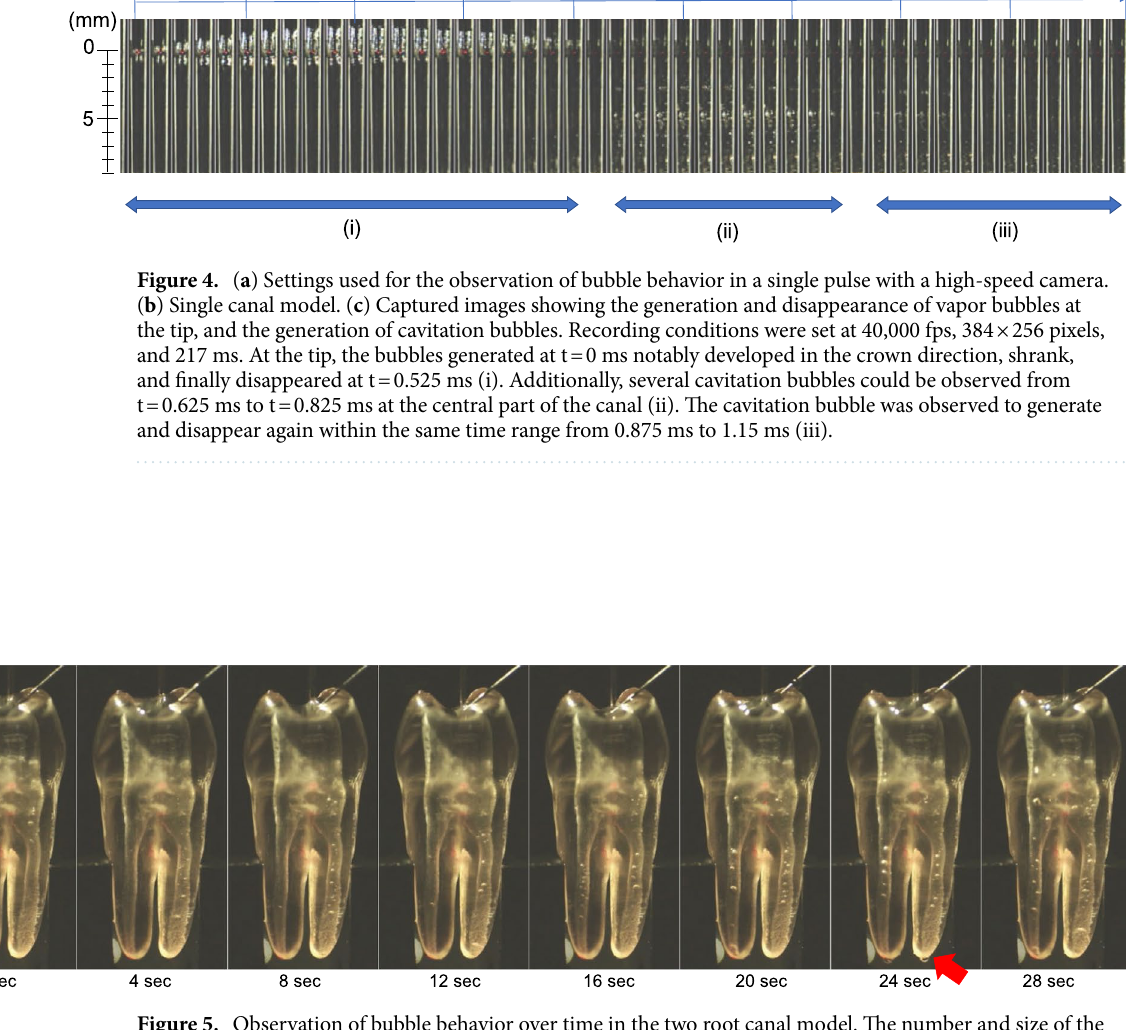
Figure 5. Observation of bubble behavior over time in the two root canal model. The number and size of the bubbles in the root canal increased with time from 0 s at the time of laser irradiation, and bubbles were observed over a wide range from the coronal area to the apex of both root canals. A slight overflow of the solution was observed from the apex at 24 s (red arrow). Recording conditions were set at 750 fps, 1024 × 1024 pixels, and 29